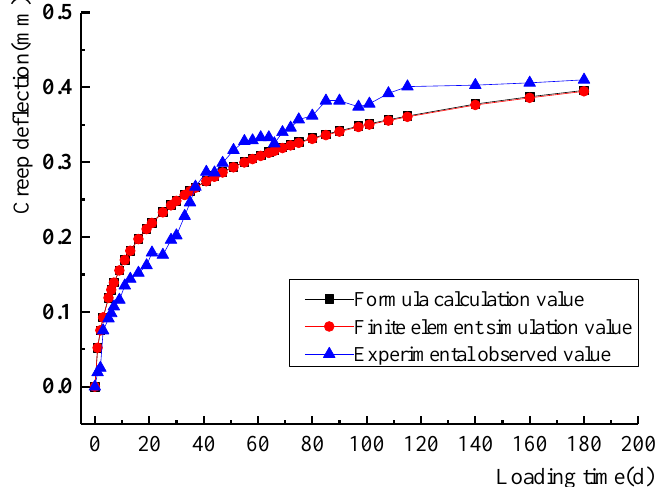
Figure 8. Creep-time curve of specimen TBB3.